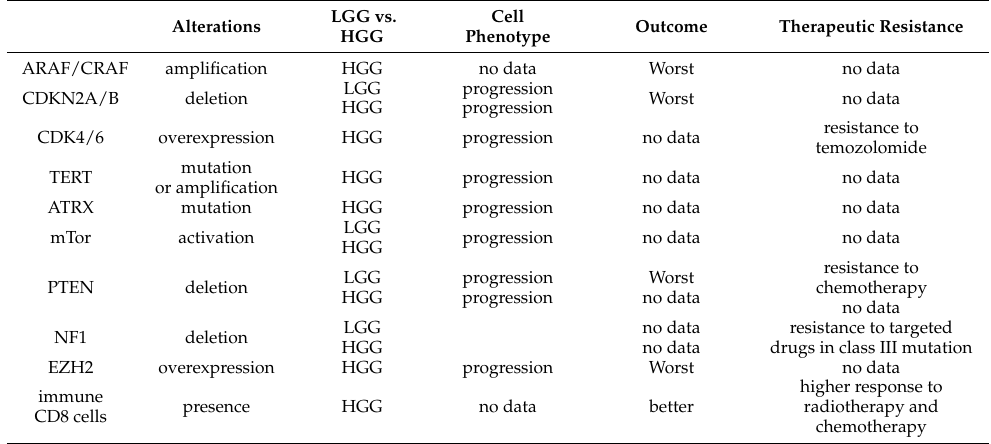
Table 1. Summary of all co-alterations evidenced in BRAFv600-mutant gliomas and their